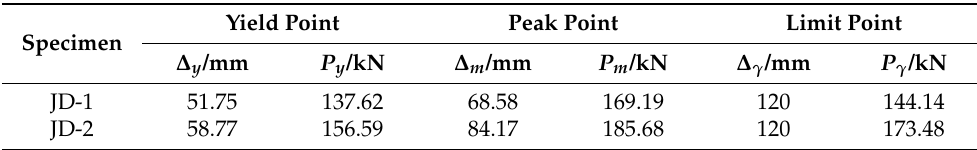
Table 3. Characteristic values on skeleton curves of